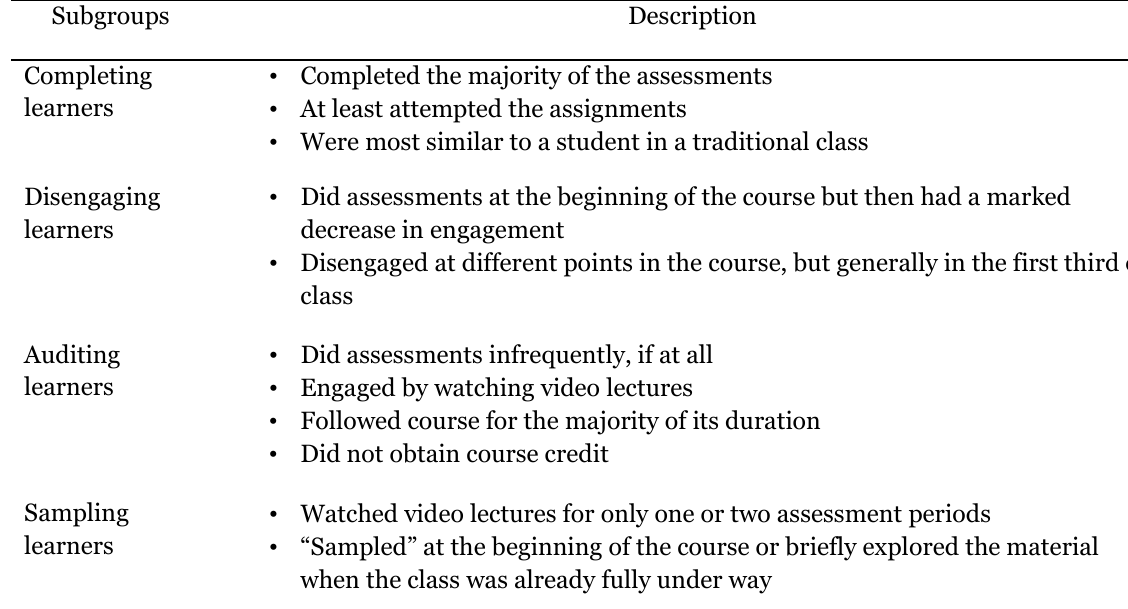
The Trajectory of Engagement by Subgroups in MOOCs Subgroups